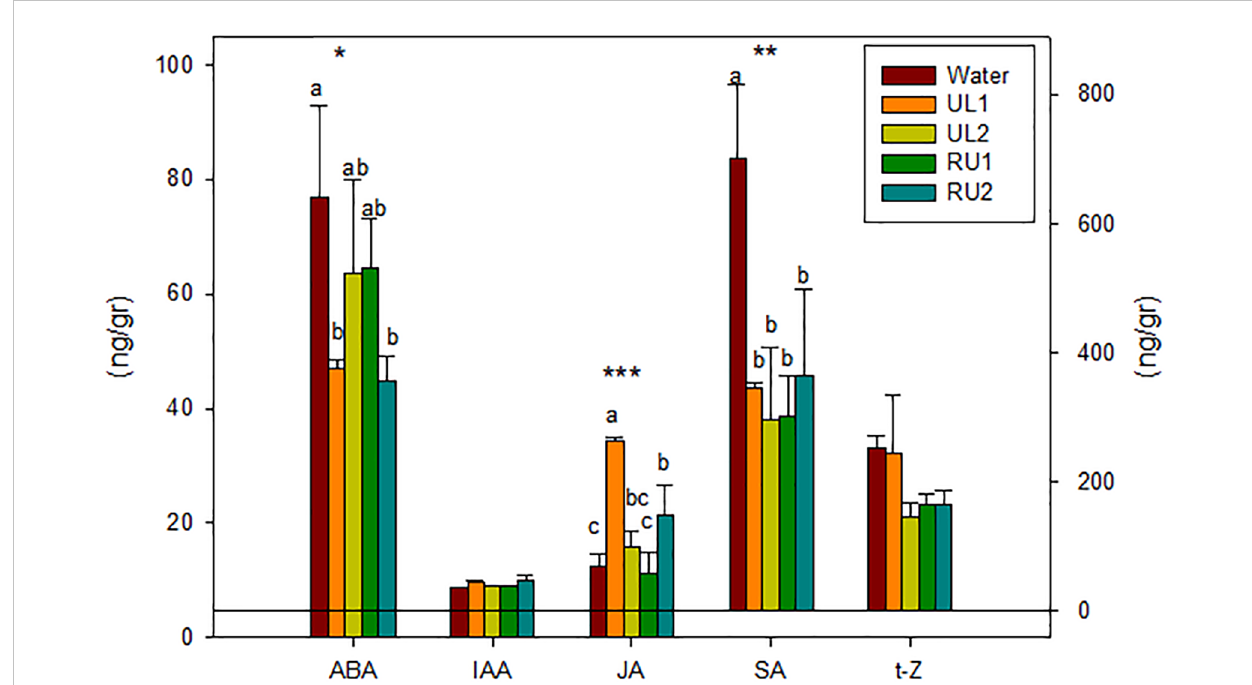
FIGURE 3 Leaves phytohormones content 24 hours after fi rst treatment (TTO_1, 24h) (ng/g DW). ABA, Abscisic acid; IAA, Indolacetic acid; JA, Jasmonic acid; SA, Salycilic acid; t-Z, trans-zeatine. Analyses of variance. levels of signi fi cance (LS): *p < 0.05, **p < 0.01, ***p <